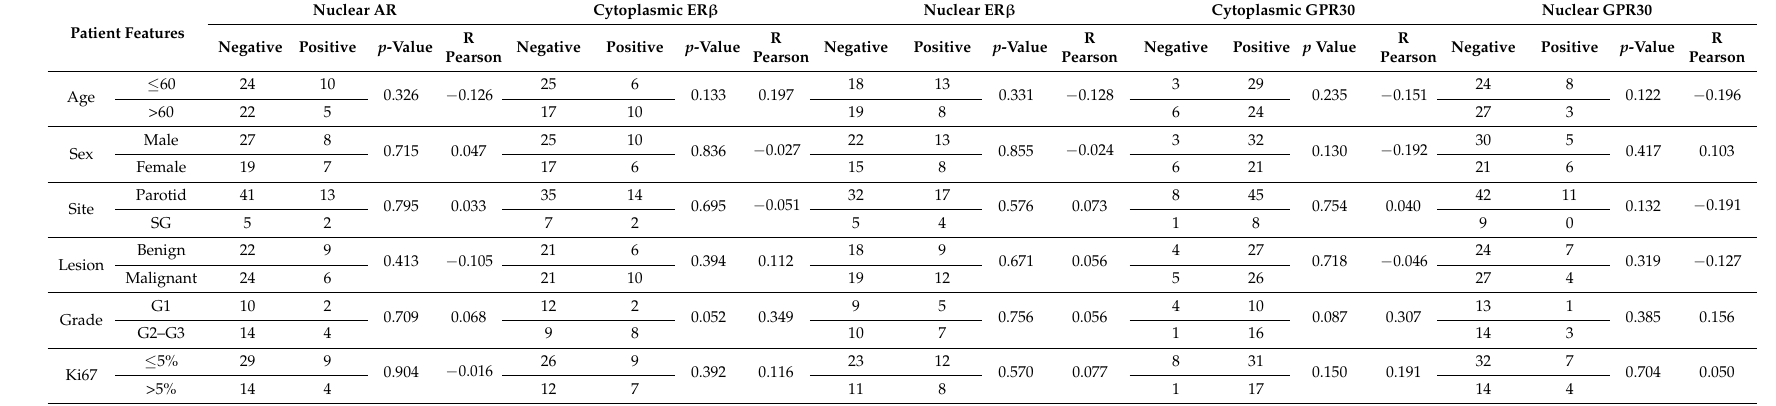
Table 2. Statistical association of AR, ER β and GPR30 tumor expression with clinical pathological features of SGT patients. (SG = Submandibular